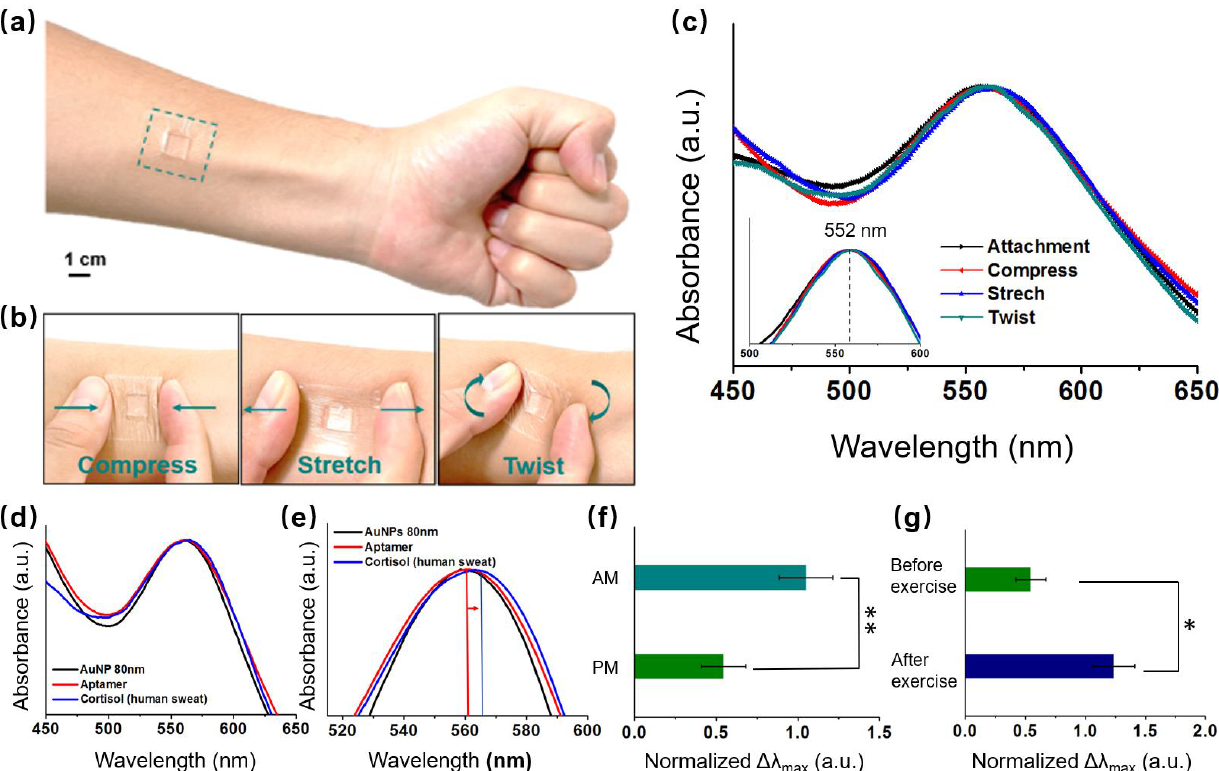
Figure 5. Schematic of the sweat biosensors ( a ) attached, ( b ) compressed, stretched, and twisted on the skin to extract cortisol. ( c ) UV-Vis spectra of the extinction peaks of the LSPR biosensor at the different statuses (6a,6b). ( d ) UV-Vis spectra of the extinction peaks following aptamer and cortisol (from human skin) conjugation with 80 nm AuNPs. ( e ) UV-Vis spectra of magnified extinction spectra, following aptamer and cortisol conjugation with AuNPs. The cortisol levels of the LSPR flexible biosensor in the human epidermis ( f ) in the morning and afternoon, and ( g ) before and after exercise (n = 4; * p < 0.05, ** p < 0.01, Student’s t -test).